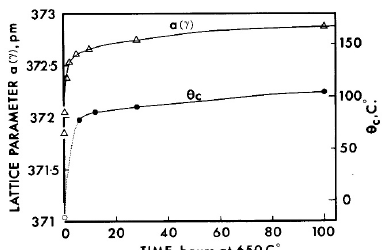
Figure 6. Graph showing changes in austenite lattice parameter and Curie temperature with ordering time at 650 ◦ C for Fe-24.5 at. % Pt alloy [49].